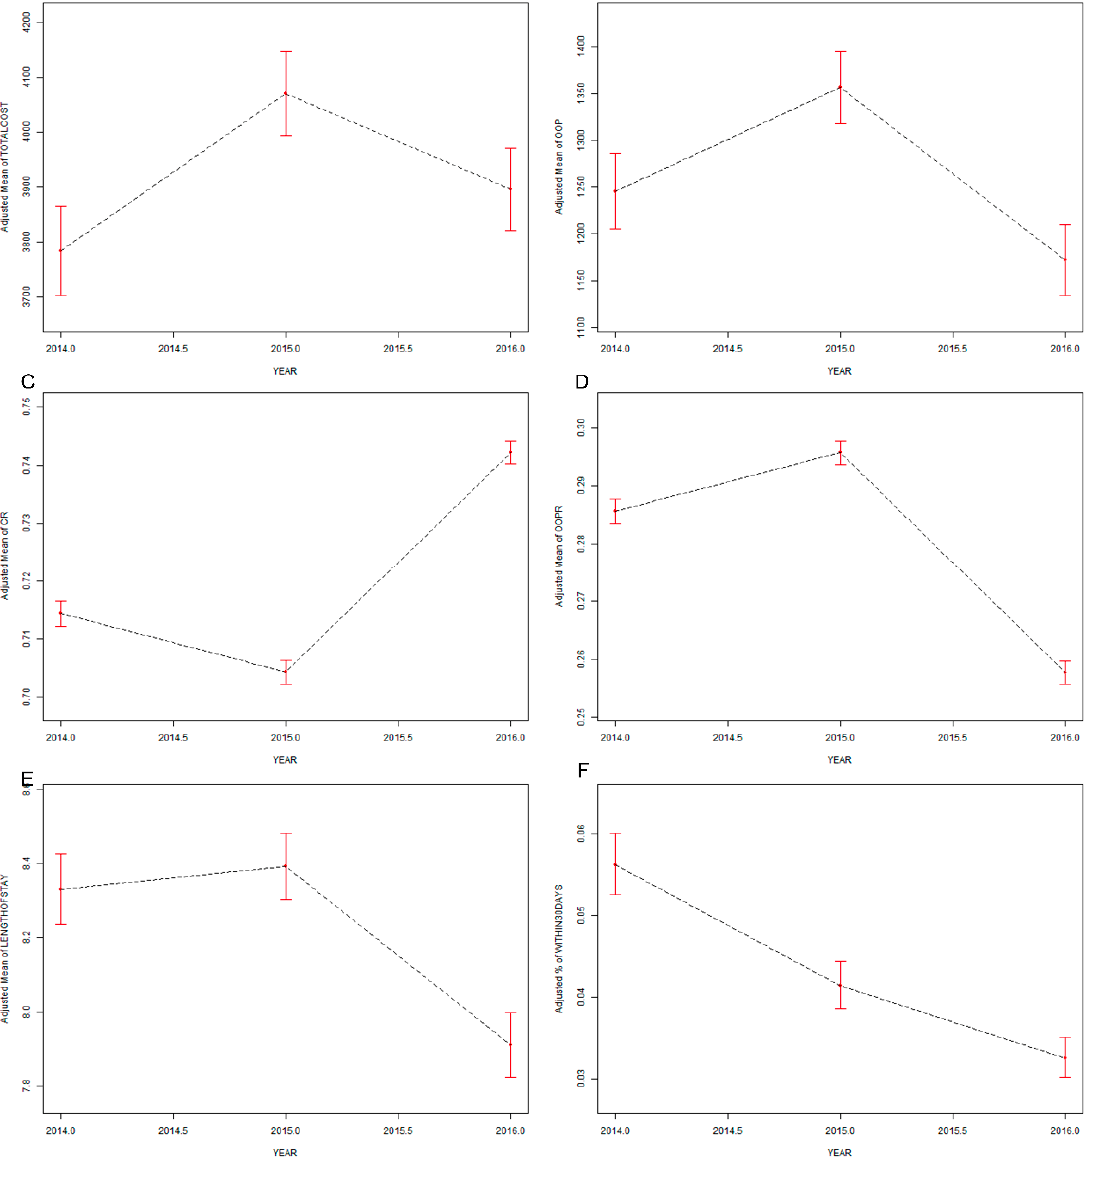
Figure 1. Direct economic burden and service quality for the whole sample. Ordinate: ( A ) adjusted mean of total costs; ( B ) adjusted mean of out-of-pocket (OOP) expenditures; ( C ) adjusted mean of the compensation ratio (CR); ( D ) adjusted mean of the OOP ratio; ( E ) adjusted mean of length of stay; ( F ) adjusted mean of the 30-day readmission (R30) rate.